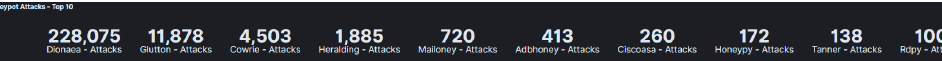
Figure 1. AWS Honeypot Attacks—Top 10.